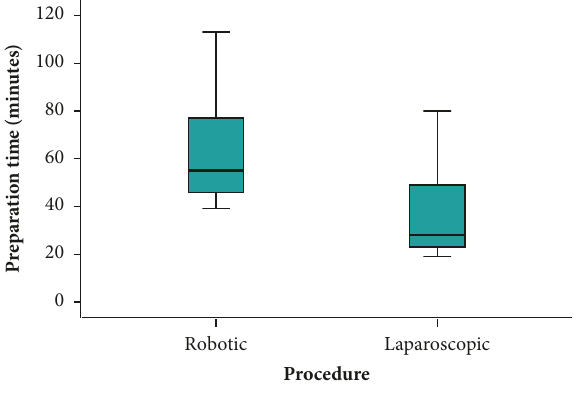
Figure 4: Preparation time. Figure 5: Actual operative